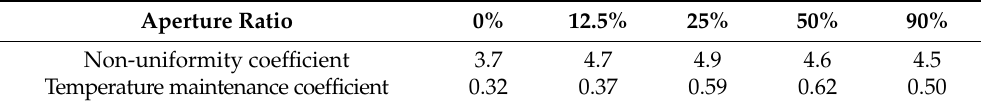
Table 1. The temperature inhomogeneity coefficients under different shelf aperture ratios.